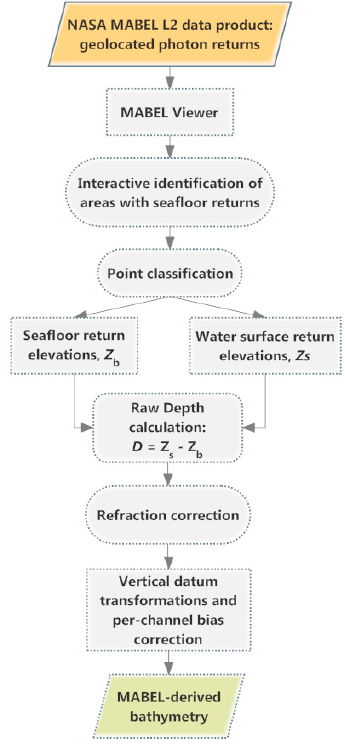
Figure 6. Workflow for generating bathymetry from MABEL data.